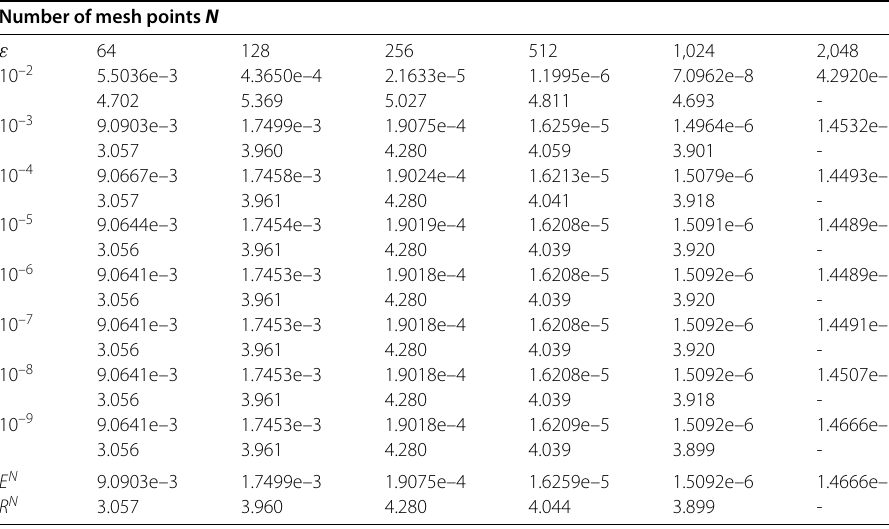
Table 2 Error estimates and convergence rates for various N for Example